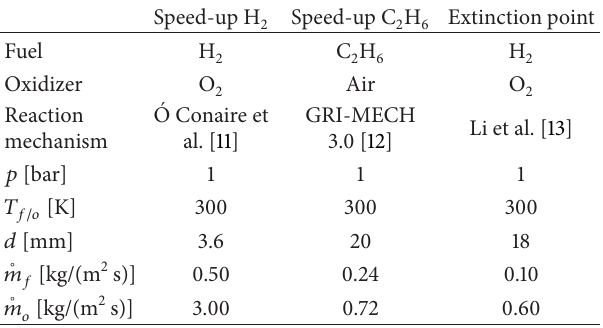
Table 2: The initial parameters of the example counterflow flame simulations.